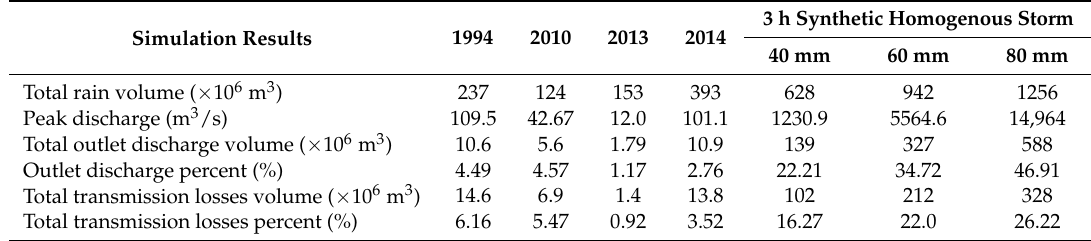
Table 2. Summary of target flood events simulated at Wadi